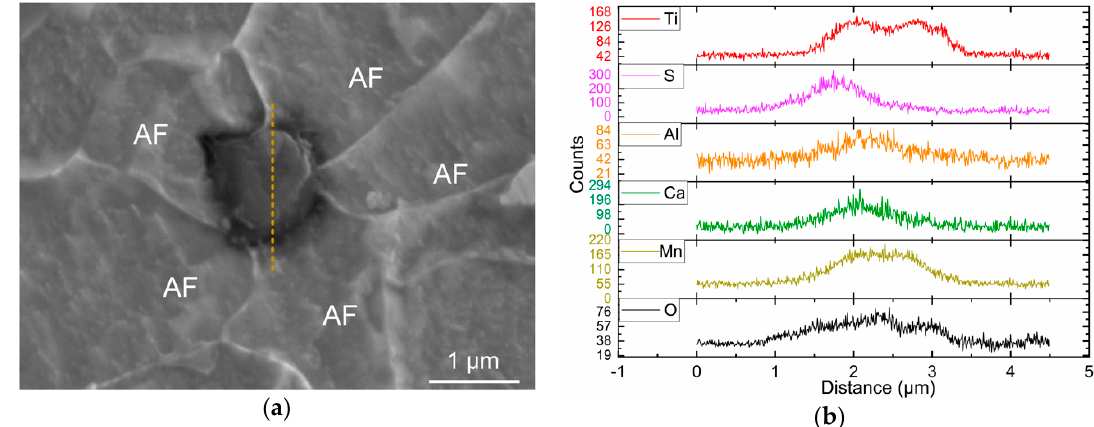
Figure 10. ( a ) EPMA micrograph of an inclusion nucleating AF in TC# steel and ( b ) line scanning analysis across the inclusion by wavelength dispersive spectroscopy (WDS).